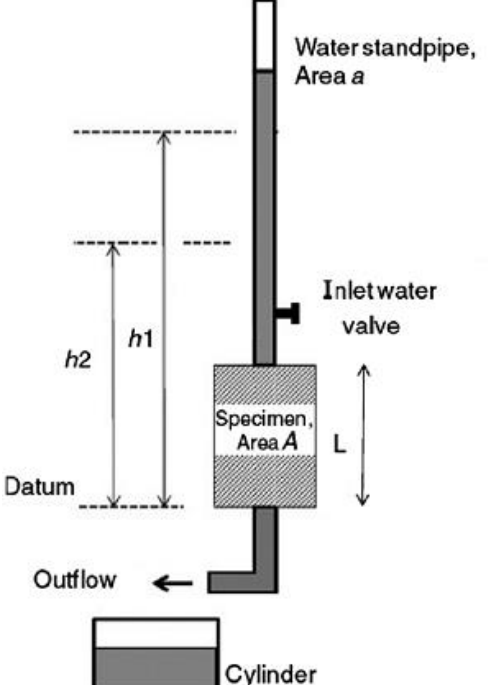
Fig. 3. Schematic of a variable head permeability test equipment (Tajdini et al., 2018)